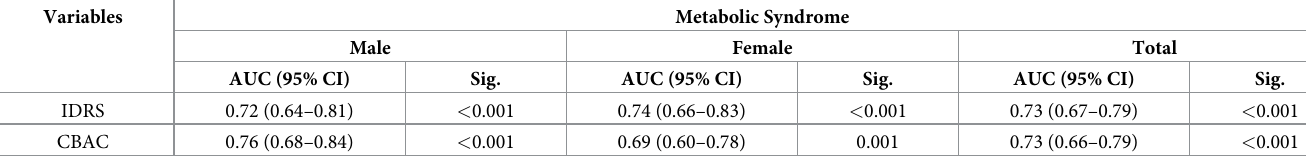
Table 2. Area Under the Curve (AUC) and level of significance for ROC curves.